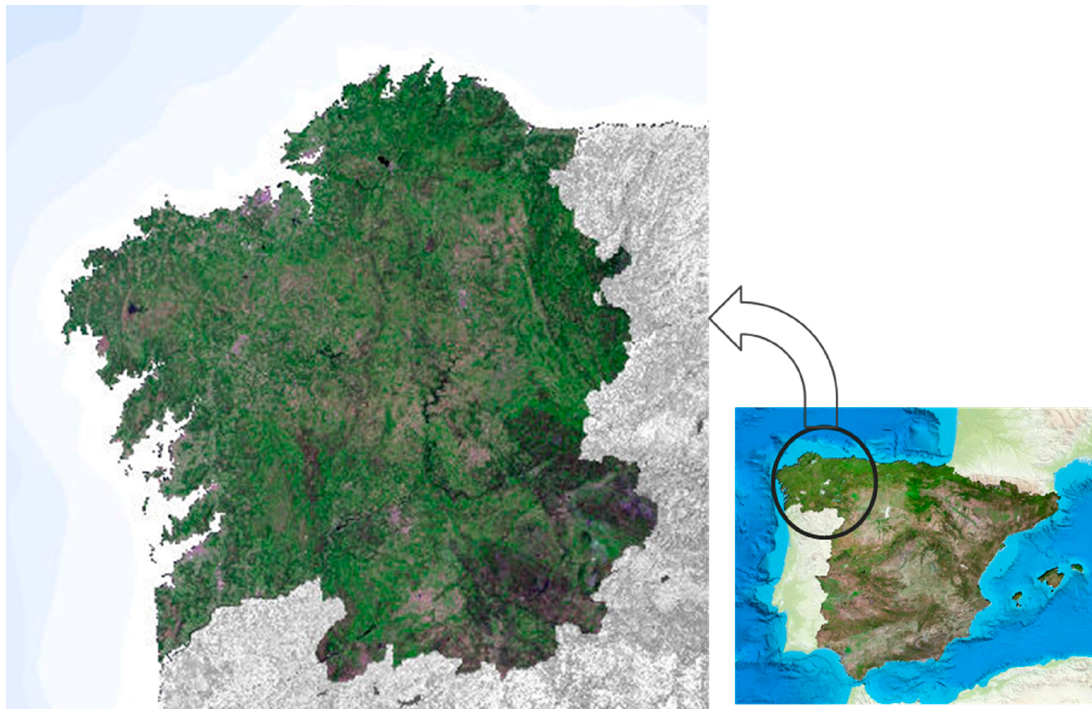
Figure 2. The region of Galicia in the North of Spain.